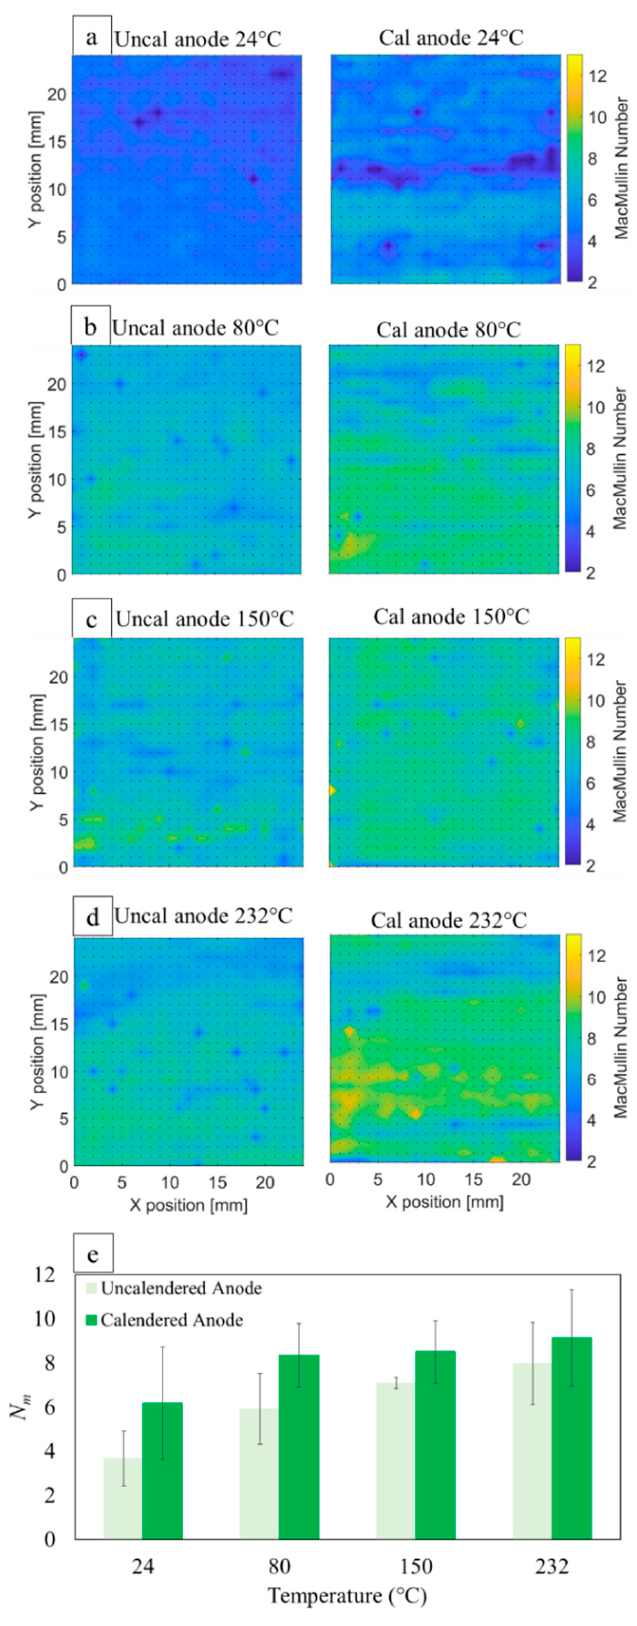
Figure 12. Ionic-resistance maps of uncalendered/calendered anodes dried at ( a ) 24 °C, ( b ) 80 °C, ( c ) 150 °C, and ( d ) 232 °C, and ( e ) comparison between the average ionic resistances of anodes before and after calendering.